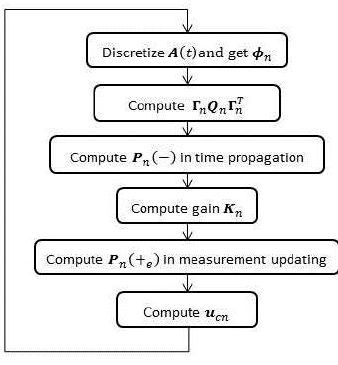
Figure 1. Iterative closed-loop Kalman filtering